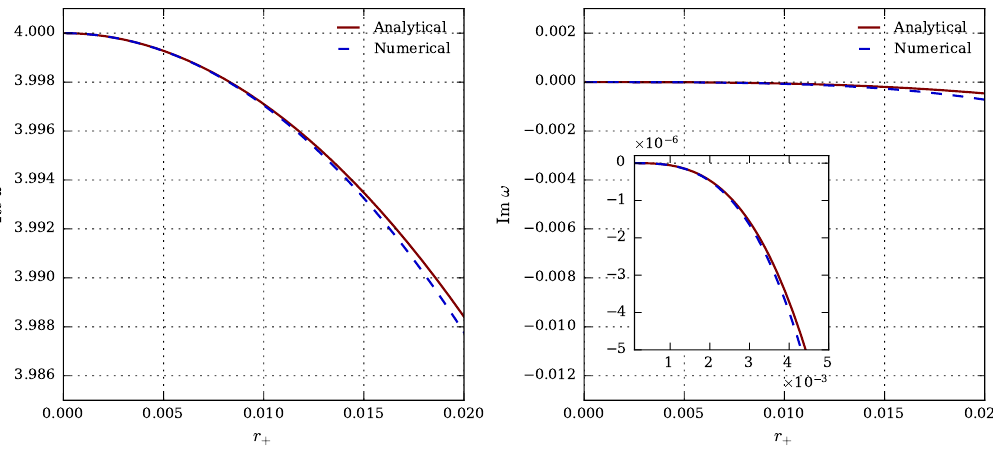
Figure 3 . The expression for the fundamental mode ω 1 , 0 , 0 , 0 given by (3.67) compared with nu- merical results for (cid:15) = 10 − 6 and α 2